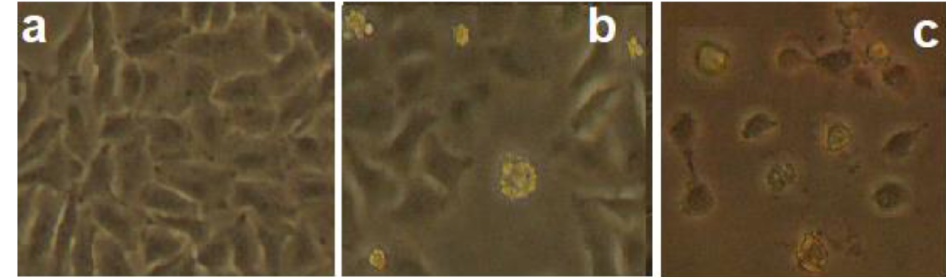
Fig. 5. Images of MDAMB-231 cells after drug delivery at different time interval (a) at 0 time, (b) after 30 min and (c) after 60 min.